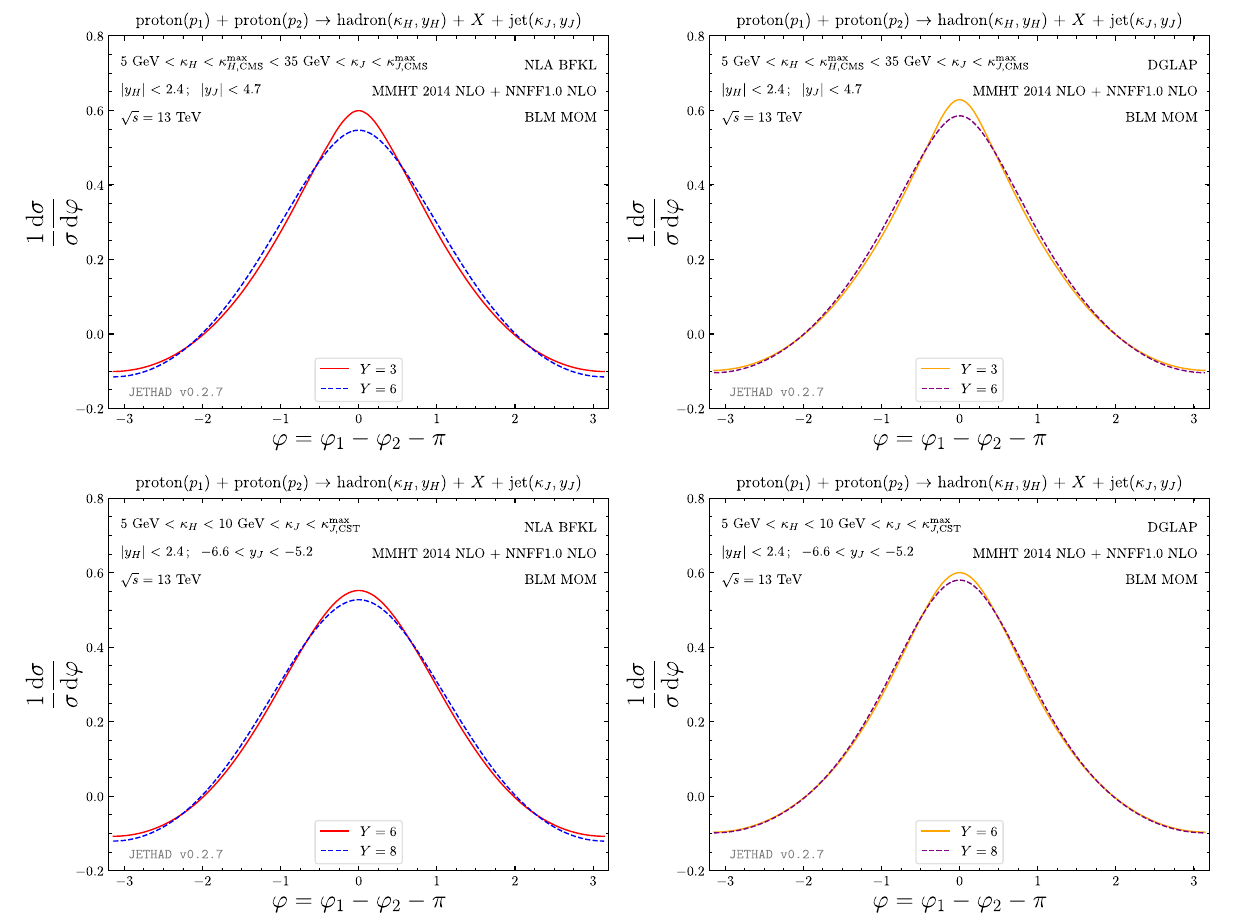
√ s = 13. Results in the asymmetric CMS rapidity interval, Y , and ( CASTOR-jet ) configuration are given in upper (lower) panels